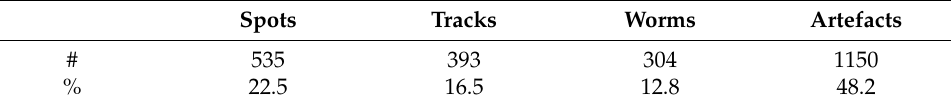
Table 2. Class multiplicities in the annotated data set. The symbol # indicates the cardinality of a subset for a given class, and % indicates the relative quantitative contribution of such a subset to the entire training set. Spots Tracks